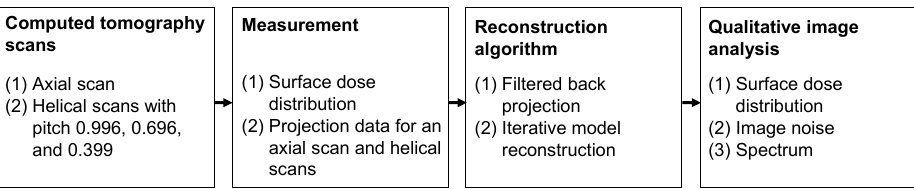
Figure 1. Measurement and analysis of the e ff ect of pitch on 256-slice CT scans.